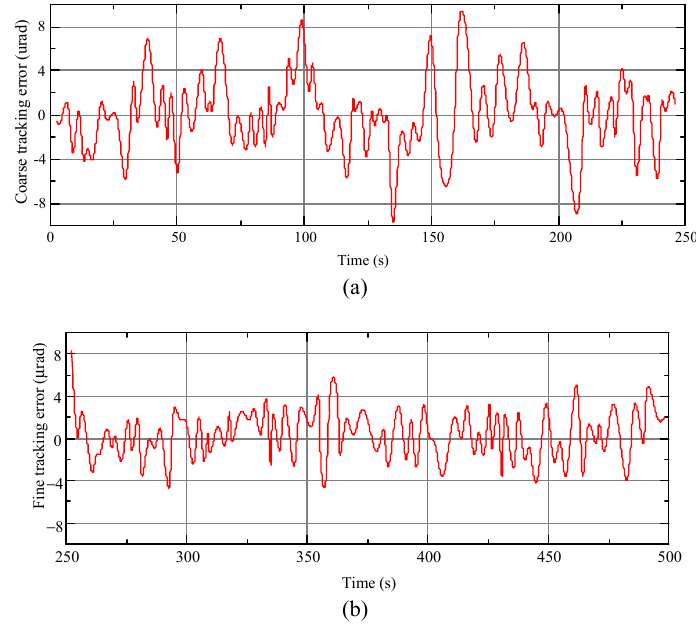
Fig. 8 Flight tracking precision test: (a) coarse tracking error and (b) fine tracking